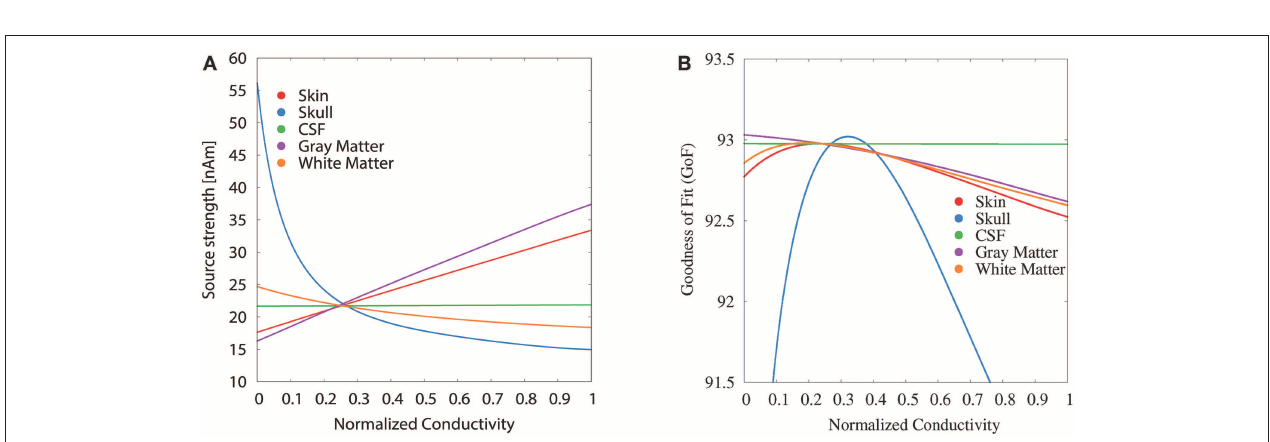
FIGURE 4 | Visualization of the source localizations for the multivariate distribution overlaid on the T1-MRI showing the full head (A–C) and a detail around the source locations (D–F) . From left to right showing sagittal (A,D) , coronal (B,E) , and axial slices (C,F) . Color bar ranges from low frequency of source localizations (blue) to high frequency of source localizations (red). Values are normalized to the maximum for each slice.